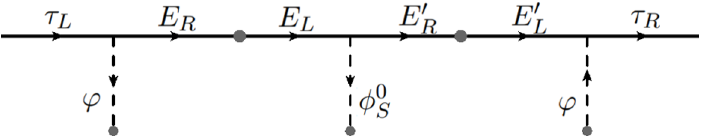
Figure 14 . Feynman diagrams generating the tau lepton masses in the SU(3) H